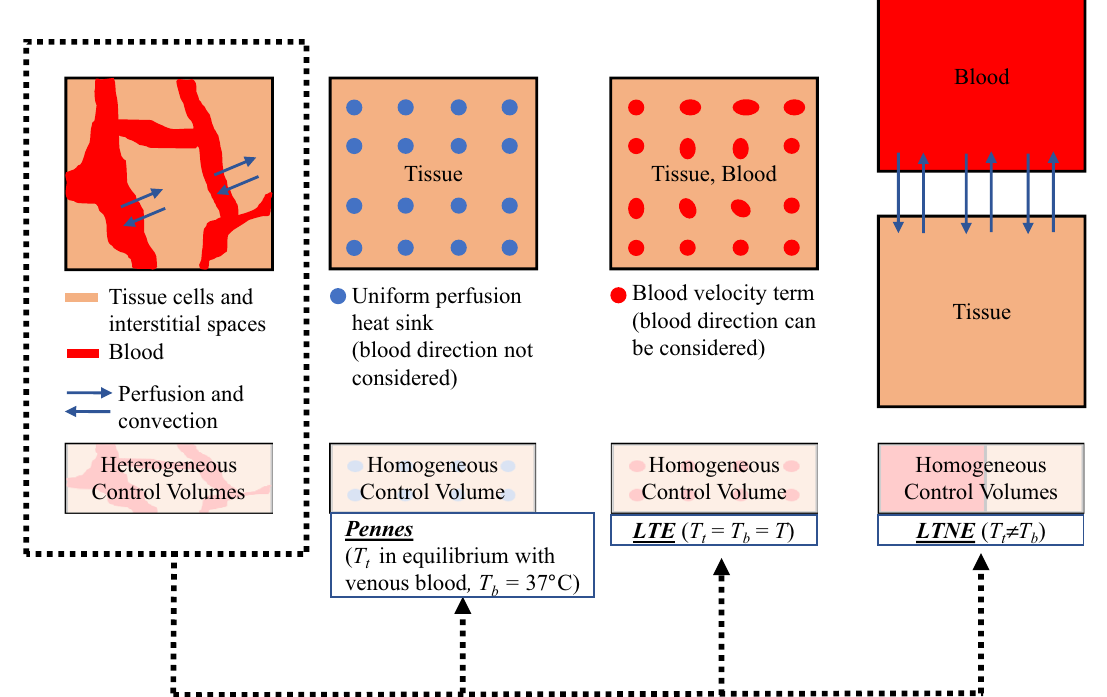
Figure 1. Differences between Pennes’ equation and porous media-based